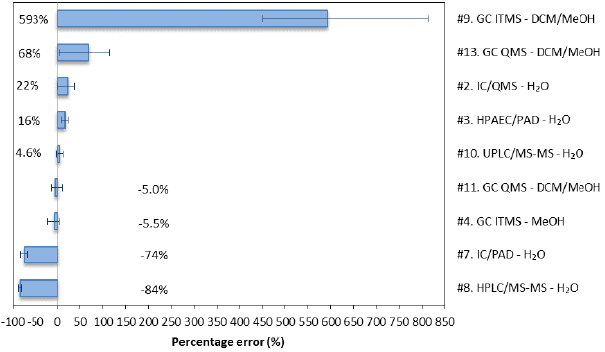
Figure 2. Calculated mean percentage error (PE) for each of the Figure 2: Calculated mean percentage error (PE) for each of the thirteen laboratories reporting thirteen laboratories reporting levels of levoglucosan in the cur- levels of levoglucosan in the current intercomparison. The PE was calculated according to eq. rent intercomparison. The PE was calculated according to Eq. (1) 1 (Section 2.5) for each of the six sectors received by the participating laboratories. The mean (Sect. 2.5) for each of the six sectors received by the participating PE for each laboratory accounts for the PE calculated for all six sectors. The laboratory number, laboratories. The mean PE for each laboratory accounts for the PE ranging from 1-13, the analytical method and solvent used for extraction are mentioned at the calculated for all six sectors. The laboratory number, ranging from right of the figure. 1–13, the analytical method and solvent used for extraction are men- tioned at the right of the figure.